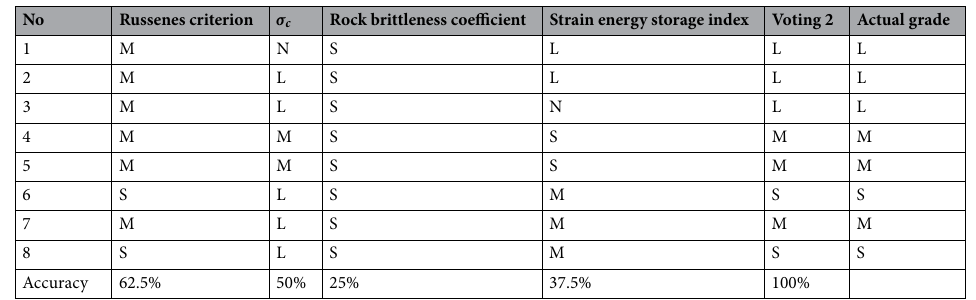
Table 18. The rockburst prediction results in Sanshandao Gold Mine. N = none rockburst, L = light rockburst, M = moderate rockburst, S = strong rockburst.